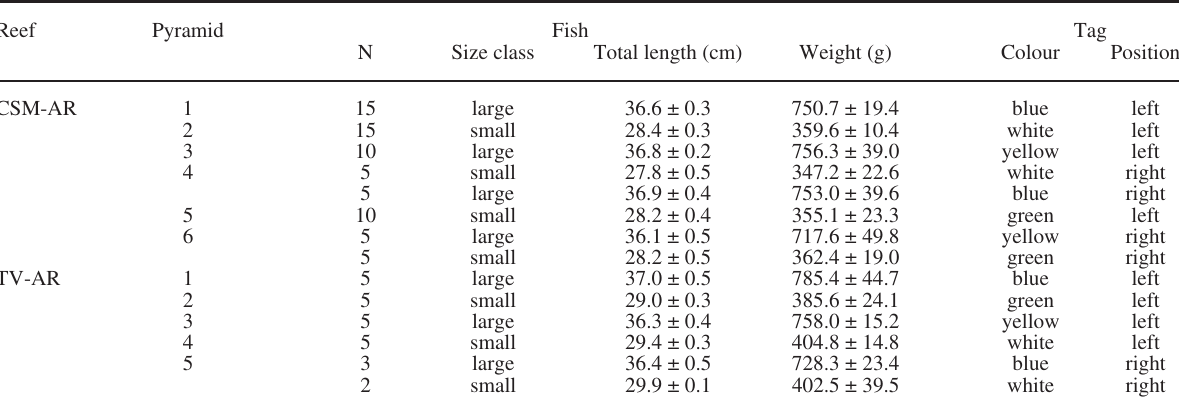
Table 1. – Number (N) and characteristics (Mean ± SE) of tagged dusky groupers released at the artificial reefs of Capo S. Marco (CSM-AR) and Torre Verdura (TV-AR). Reef